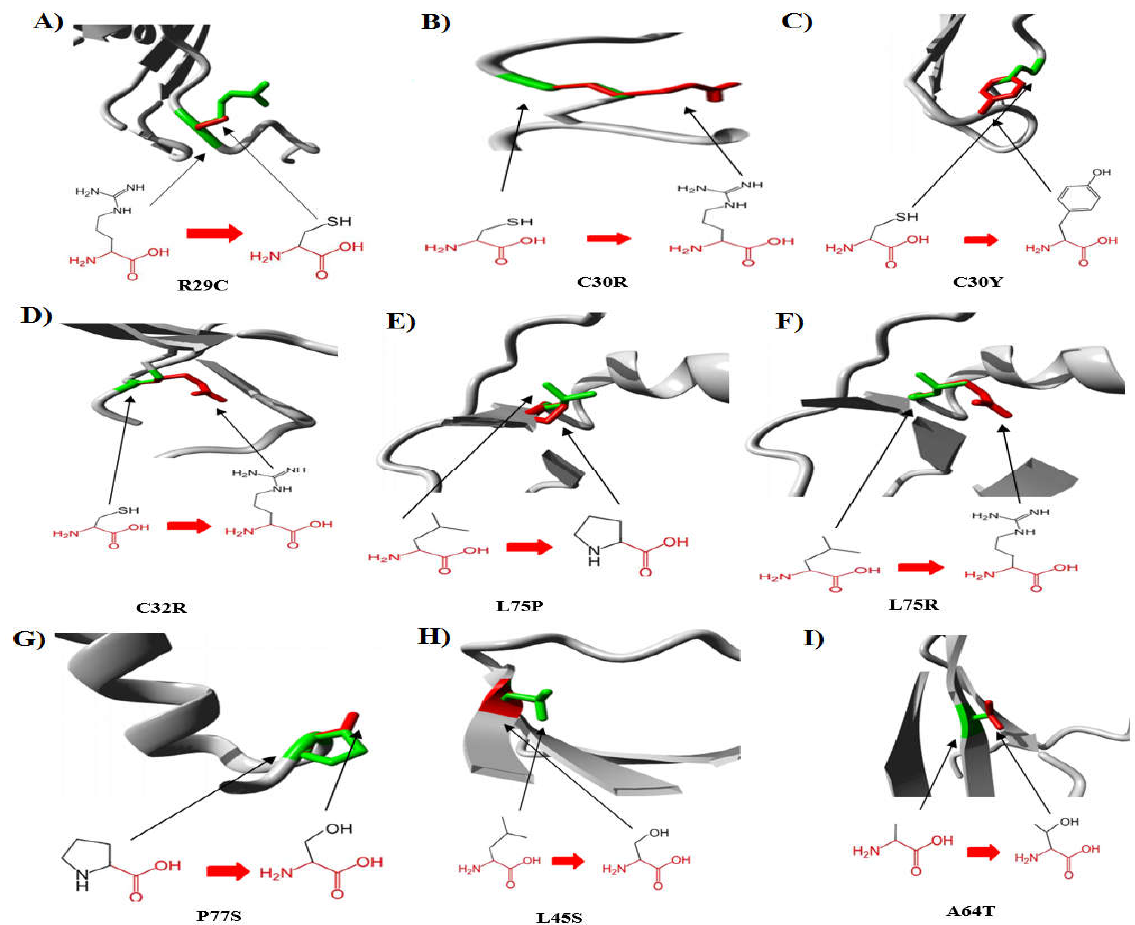
Fig. 5. Overlapped structure of the native and mutant amino acids for the most deleterious nsSNPs obtained from HOPE. The native and mutant amino acids are shown in green and red, respectively. (the color must be used): A) The charge of the native (positive) and substituted (neutral) amino acids are different, and this may result in loss of interaction. There might be a lack of external interactions, for the native residue is bigger than the mutant residue. Moreover, the hydrophobicity of the wild and mutant reside differs (Probably Damaging); B) The arginine residue is big and has a positive charge while the cysteine is small and neutral. The wild-type residue is more hydrophobic. Mutation cause in loss of the cysteine bond (destabilization of the structure and Probably damaging); C) The arginine residue is big and has a positive charge while the cysteine is small and neutral. The wild-type residue is more hydrophobic. Mutation causes loss of the cysteine bond (destabilization of the structure and Probably damaging); D) The wild-type residue charge was neutral; the mutant residue charge is positive. The mutant residue is big. The wild-type residue is more hydrophobic (Damaging and mutation of 100% conserved residue); E) The mutant residue is small (space at the core of the protein). The mutant residue was not observed in other homologous proteins, but residues with some common properties were observed. Sometimes the mutation might occur without damaging impact for the protein; F) The mutant residue makes a positive charge in the buried part of the protein (protein folding problems). The mutant residue charge is positive and big. The mutation will cause loss of hydrophobic interactions (Probably damaging); G) The wild-type residue is more hydrophobic and bigger. The mutation can disturb the special conformation caused by a proline residue (Probably damaging); H) The mutant residue is small (mutation will cause space in the core of the protein). The wild-type residue is more hydrophobic (mutation will cause loss of hydrophobic interactions). Another residue type was observed often at this position in homologous sequences, but it was not similar to this mutant residue (Probably damaging); I) The mutant residue is big and will not fit and also it will cause loss of hydrophobic interactions. Neither this mutant residue nor other residue types with similar properties was not observed at this position in homologous sequences (Probably